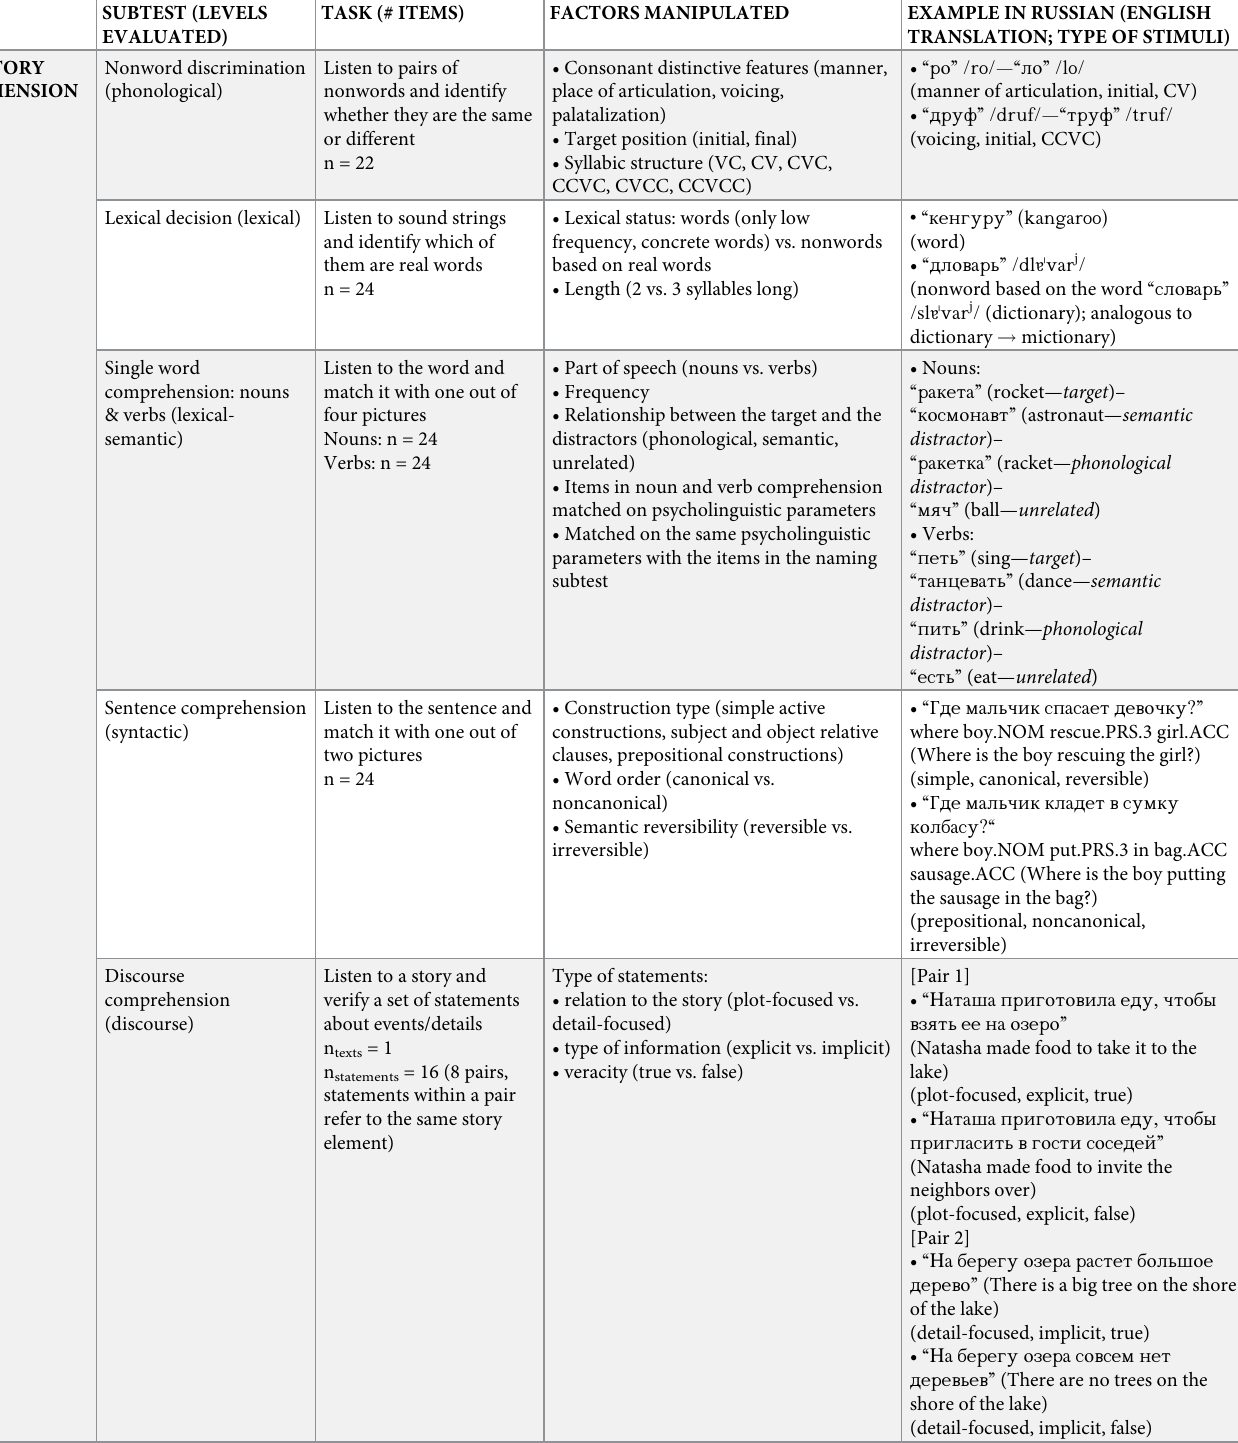
Table 3. Description of the RAT